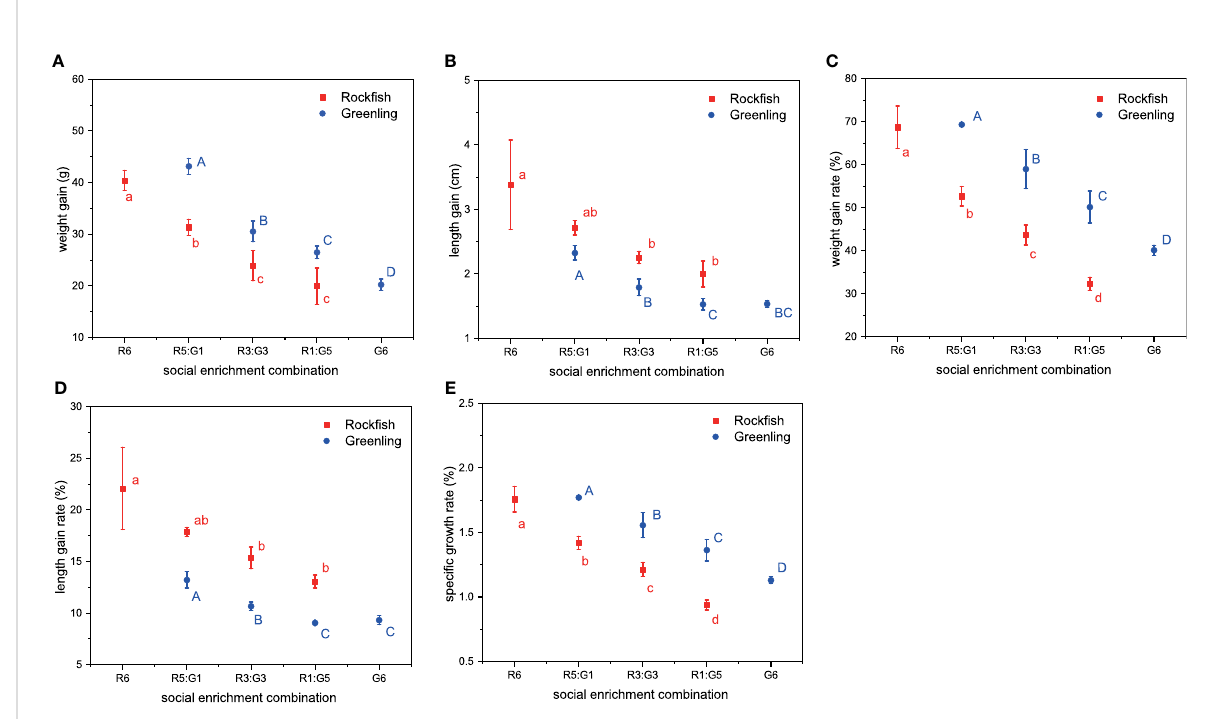
FIGURE 2 The growth performance of black rock fi sh and fat greenling from different social enrichment combinations after one-month rearing. (A) weight gain, (B) length gain, (C) weight gain rate, (D) length gain rate, (E) speci fi c growth rate. Different red, small letters indicate signi fi cant differences among social enrichment combinations within black rock fi sh, and different blue, capital letters indicate signi fi cant differences among social enrichment combinations within fat greenling. R6 means 6 rock fi sh per aquarium, R5:G1 means 5 rock fi sh and 1 greenling per aquarium, R3:G3 means 3 rock fi sh and 3 greenling per aquarium, R1:G5 means 1 rock fi sh and 5 greenling per aquarium, and G6 means 6 greenling per aquarium. n = 3. Data are presented as means ±